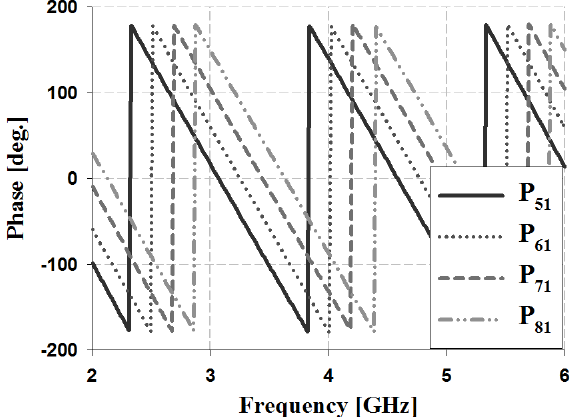
Figure 12. Simulation analysis of phase for input Port 1. Table 2. Simulation results of phase di ff erence for 4 × 4 Butler